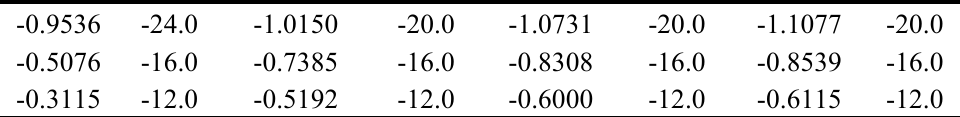
Table 2. Numbers used for plotting Figure 4 for charge on Hg electrode in contact with 1M